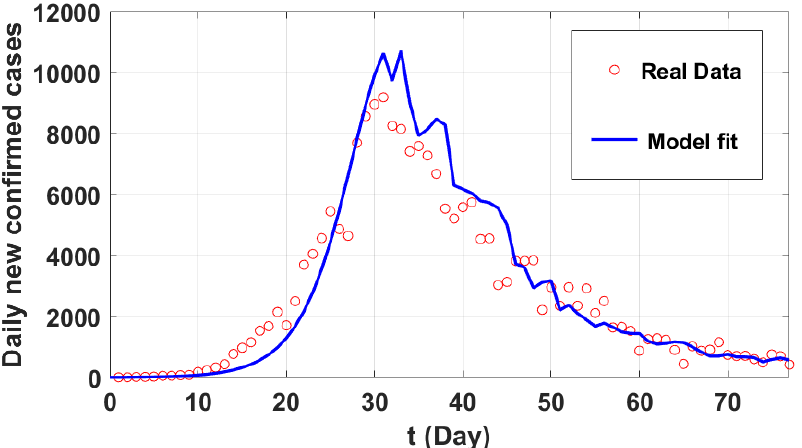
Figure 3. Numerical simulation for system (14–16) at H ∗ = 0.8, α = 0.9, α 1 = 0.87, σ 1 = σ 2 = σ 3 = 0.01, σ 4 = σ 5 = σ 6 = σ 7 = σ 8 = 0.1.